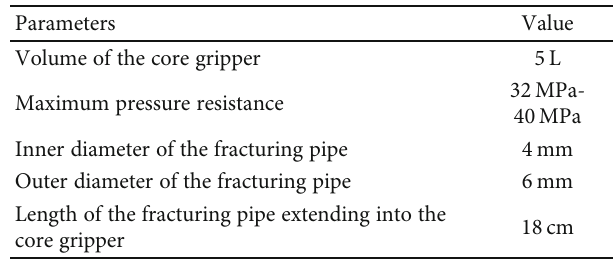
Figure 3: Schematic of hydraulic fracturing equipment. Table 1: The details of hydraulic fracturing equipment parameters.